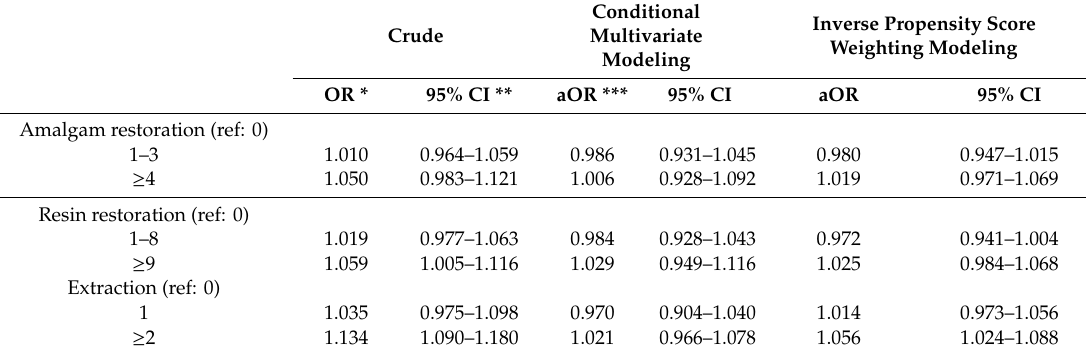
Table 2. Cont . Crude